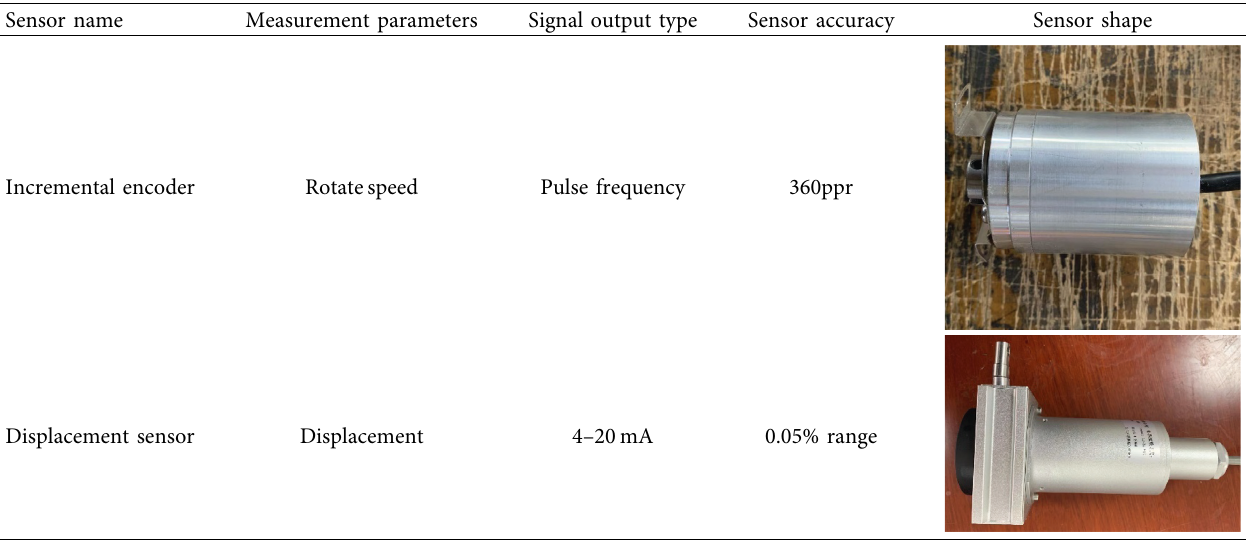
Figure 7: Application in subsea drilling rig. Table 3: List of sensor